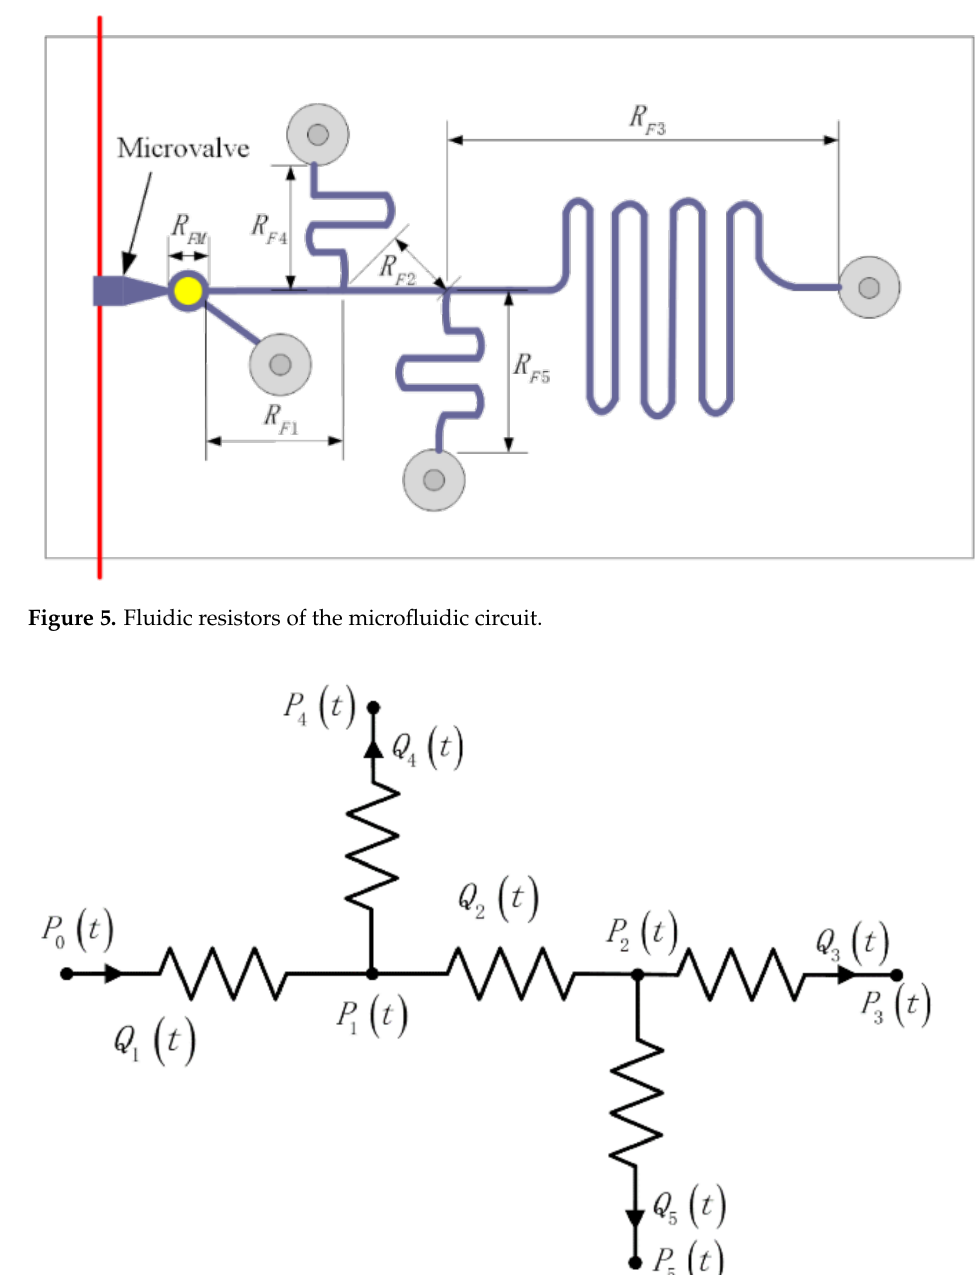
Figure 6. Electrical model of microfluidic